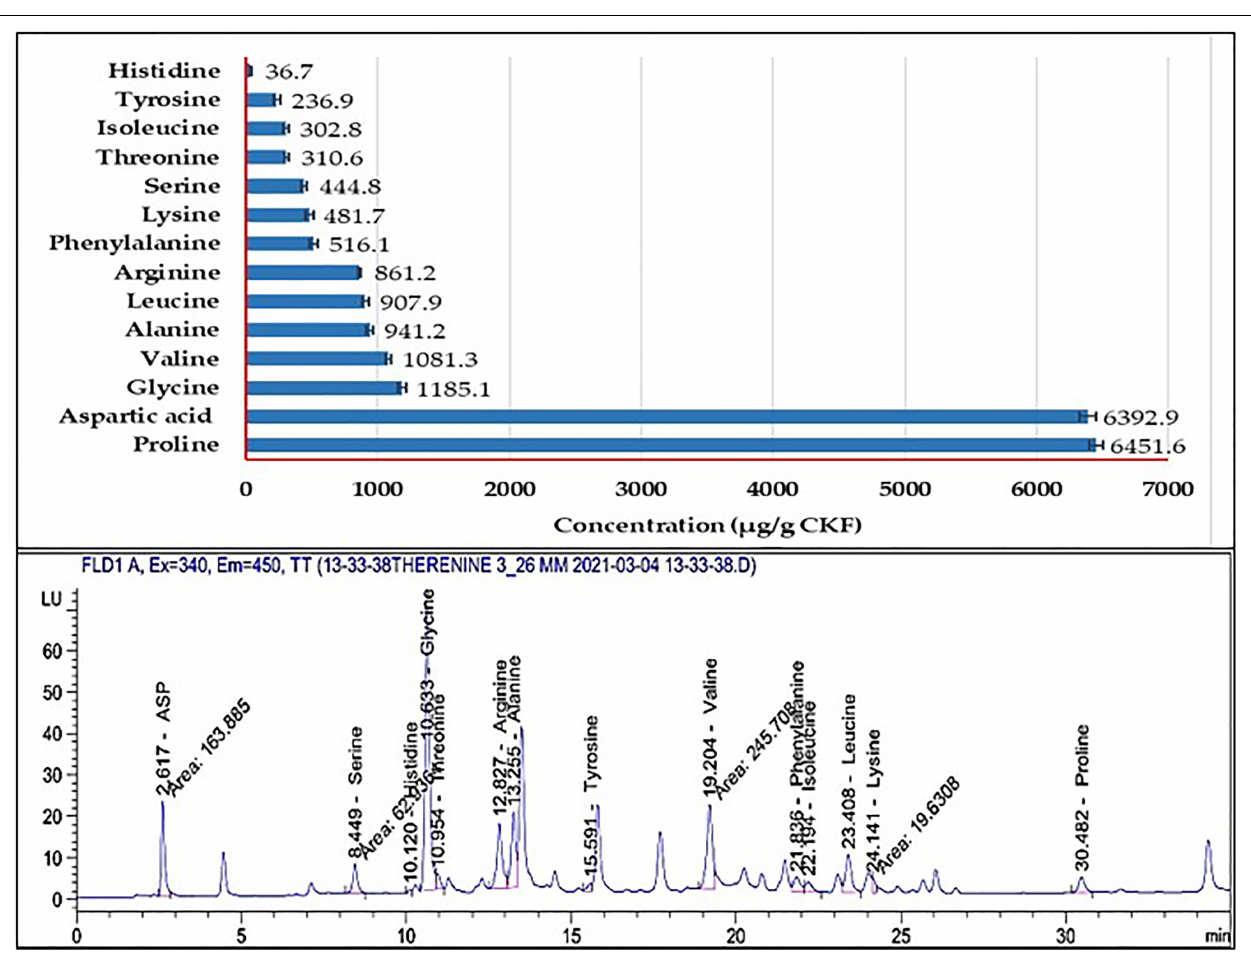
FIGURE 10 | HPLC analysis of the amino acids’ profiles released from the fermented feather by B. paramycoides ZW-5.